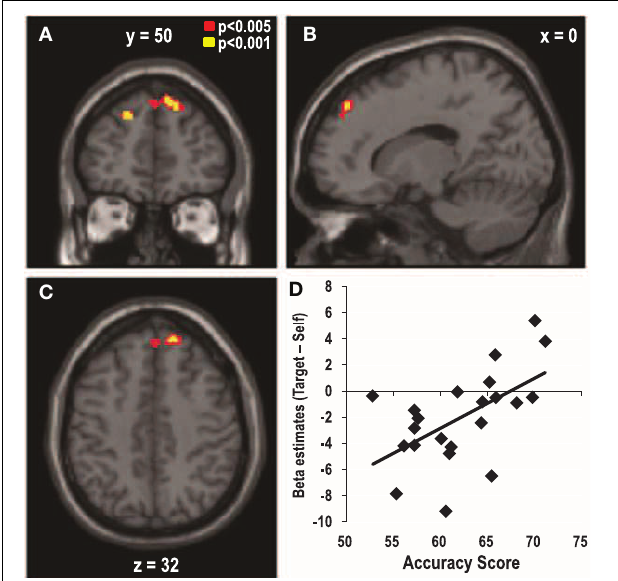
FIGURE 3 | Dorsomedial Prefrontal Cortex (DMPFC) activity predicts the accuracy of the estimations of the targets’ preferences. The DMPFC ( x = 18, y = 50, z = 40, Z = 3.42, corrected, p < 0.05) activity that occurred in response to the target- vs. self-trials during the item phase predicted the individual variability in the accuracy of estimating the preferences of the targets. (A) Coronal, (B) Sagittal, and (C) Axial views of the DMPFC. (D) Scatter plot of the beta estimates of the DMPFC in the contrast of target- vs. self-trials as a function of accuracy scores.